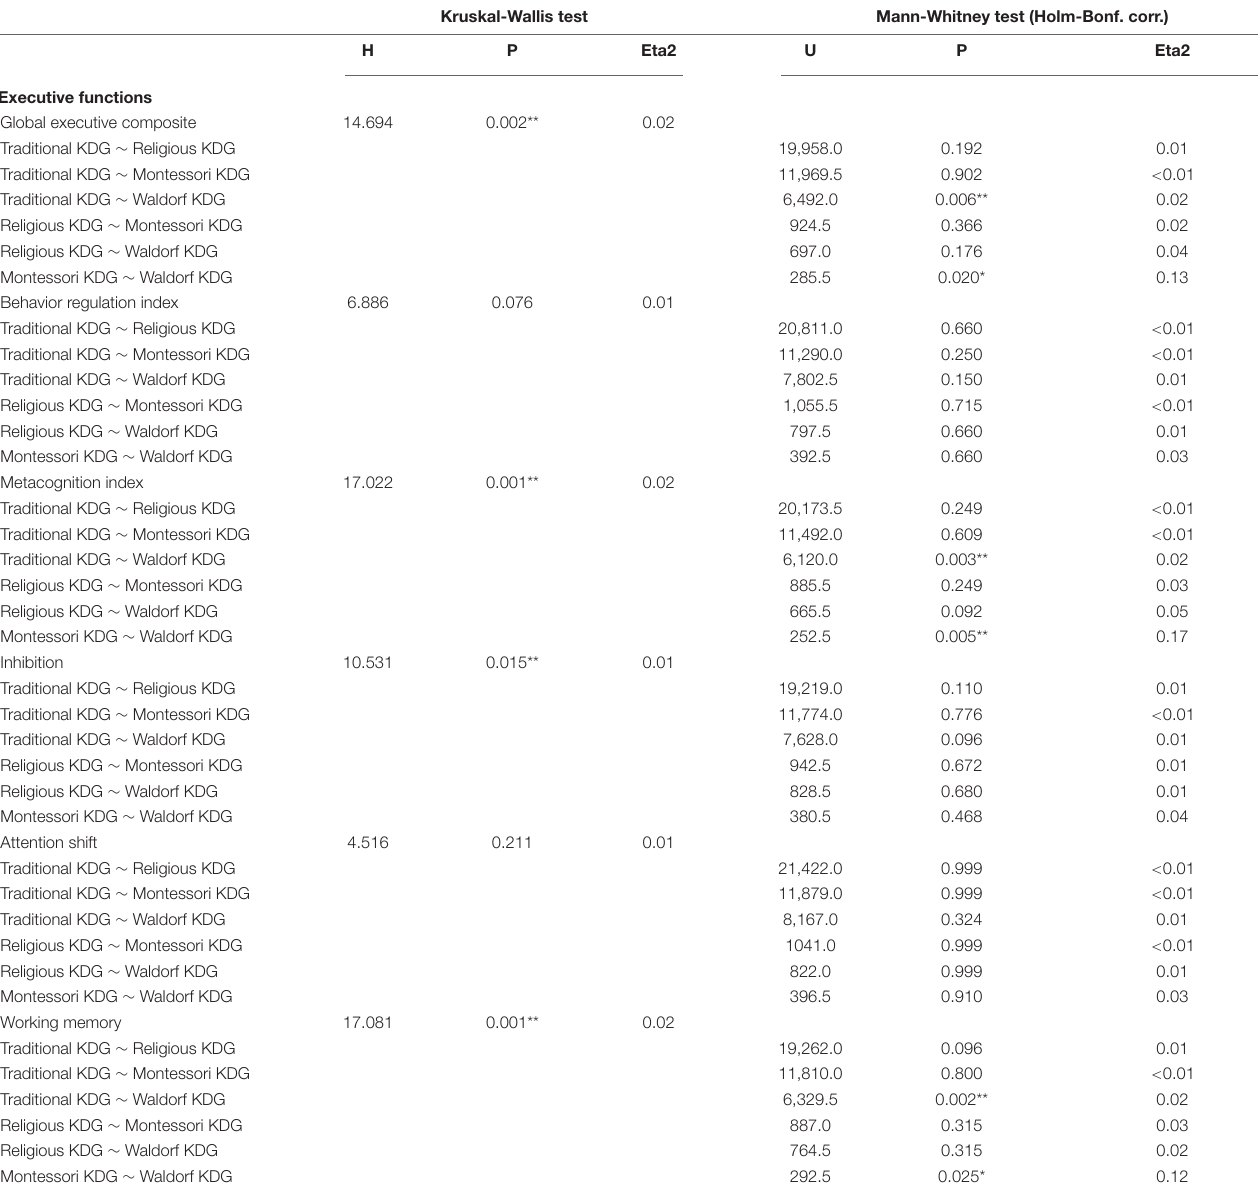
TABLE 4 | Differences in executive functions between kindergartens. Kruskal-Wallis test Mann-Whitney test (Holm-Bonf.